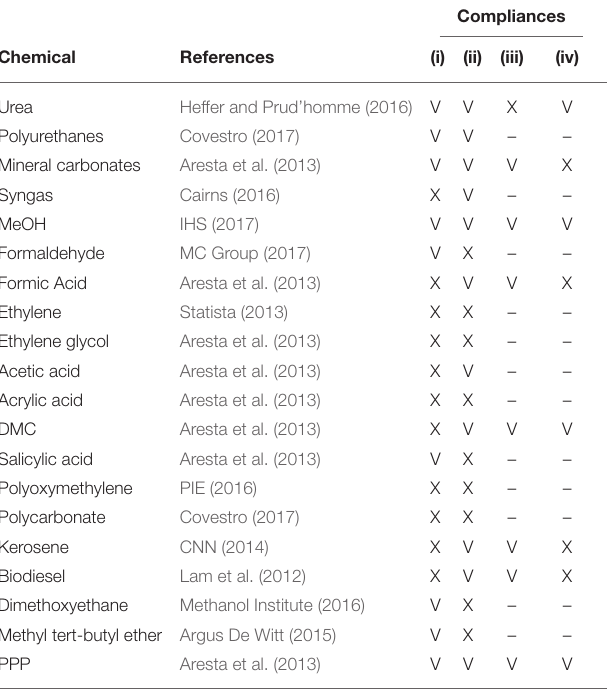
TABLE 2 | List of chemicals that can be produced from CO 2 and their effective compliance with the design requirements: (i) minimum production threshold, (ii) techno-economic data availability, (iii) environmentally promising, and (iv) economically